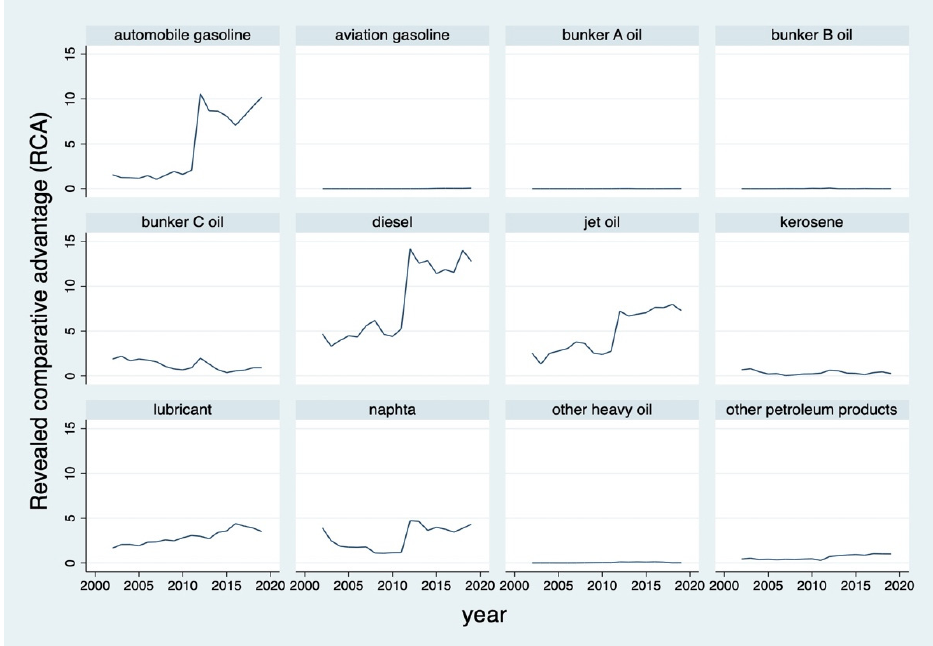
Figure 4. Revealed comparative advantage index by petroleum